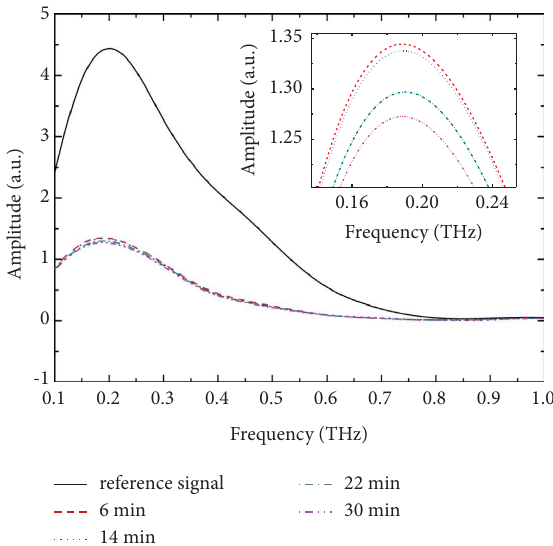
Figure 14: THz frequency-domain spectra of MWCNT aqueous dispersion under same MF intensity and diferent time.